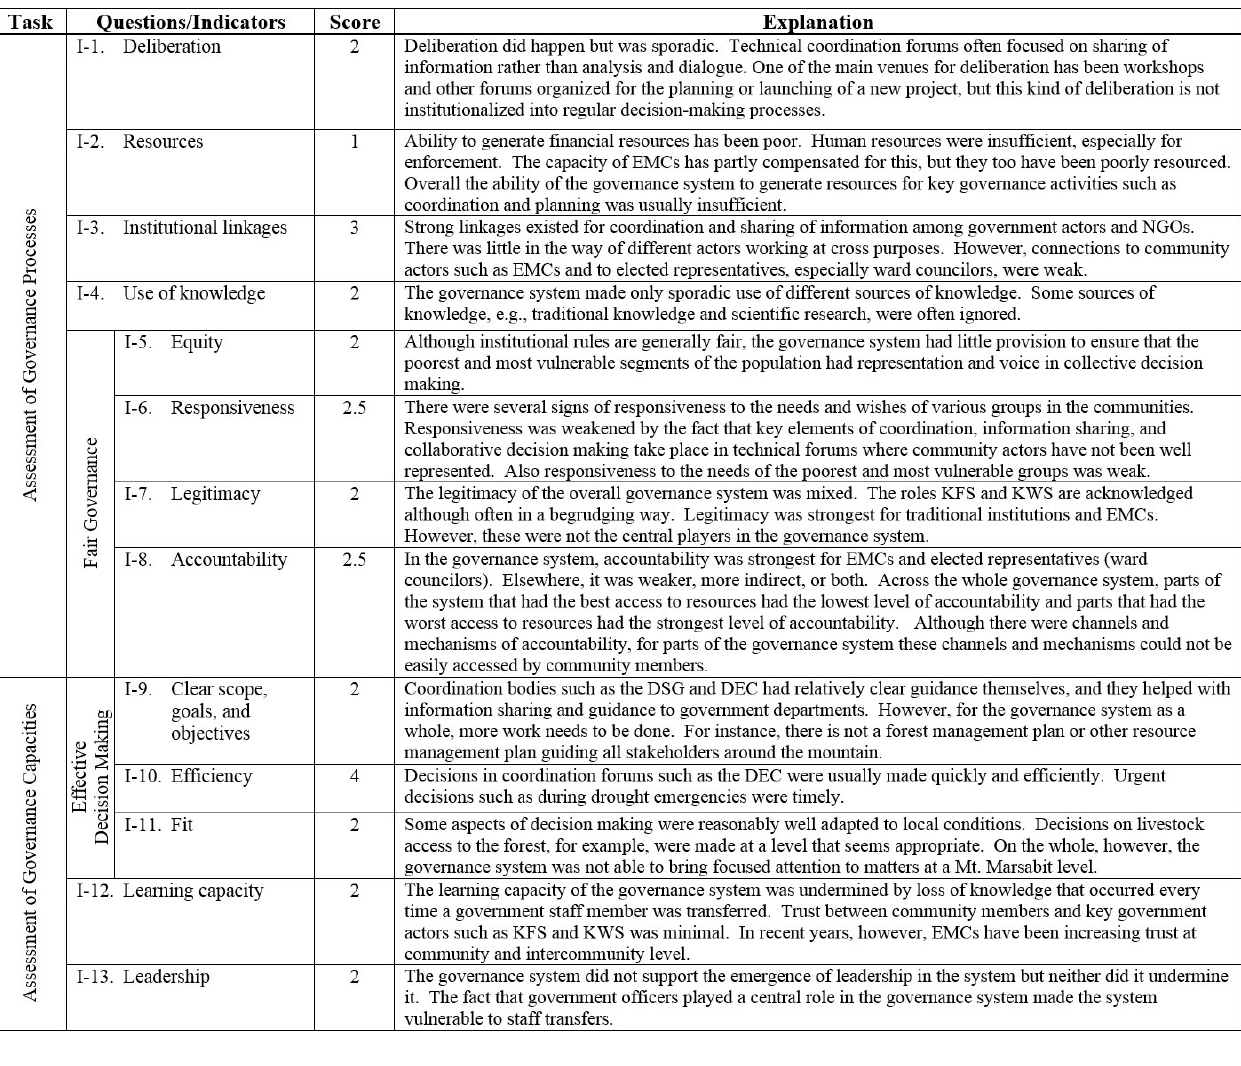
Table 2. Assessment of governance processes and capacities. (EMCs = environmental management committees; KFS = Kenya Forest Service; KWS = Kenya Wildlife Service; DEC = District Environment